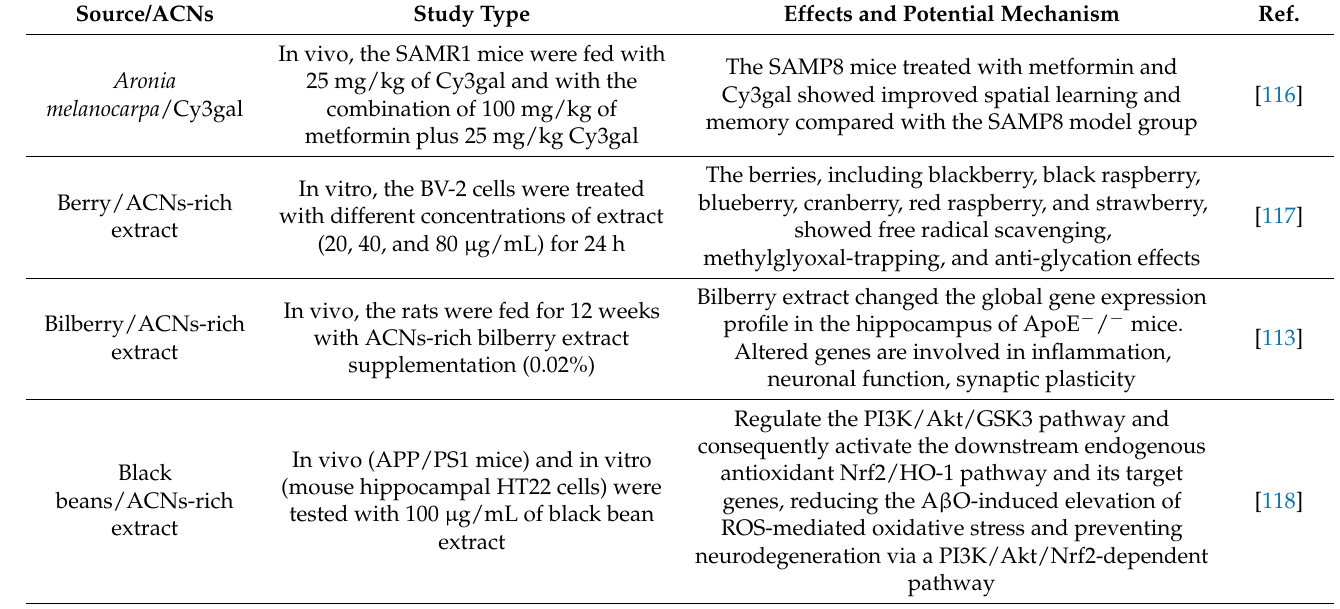
Table 3. The effects of ACNs in neurodegenerative